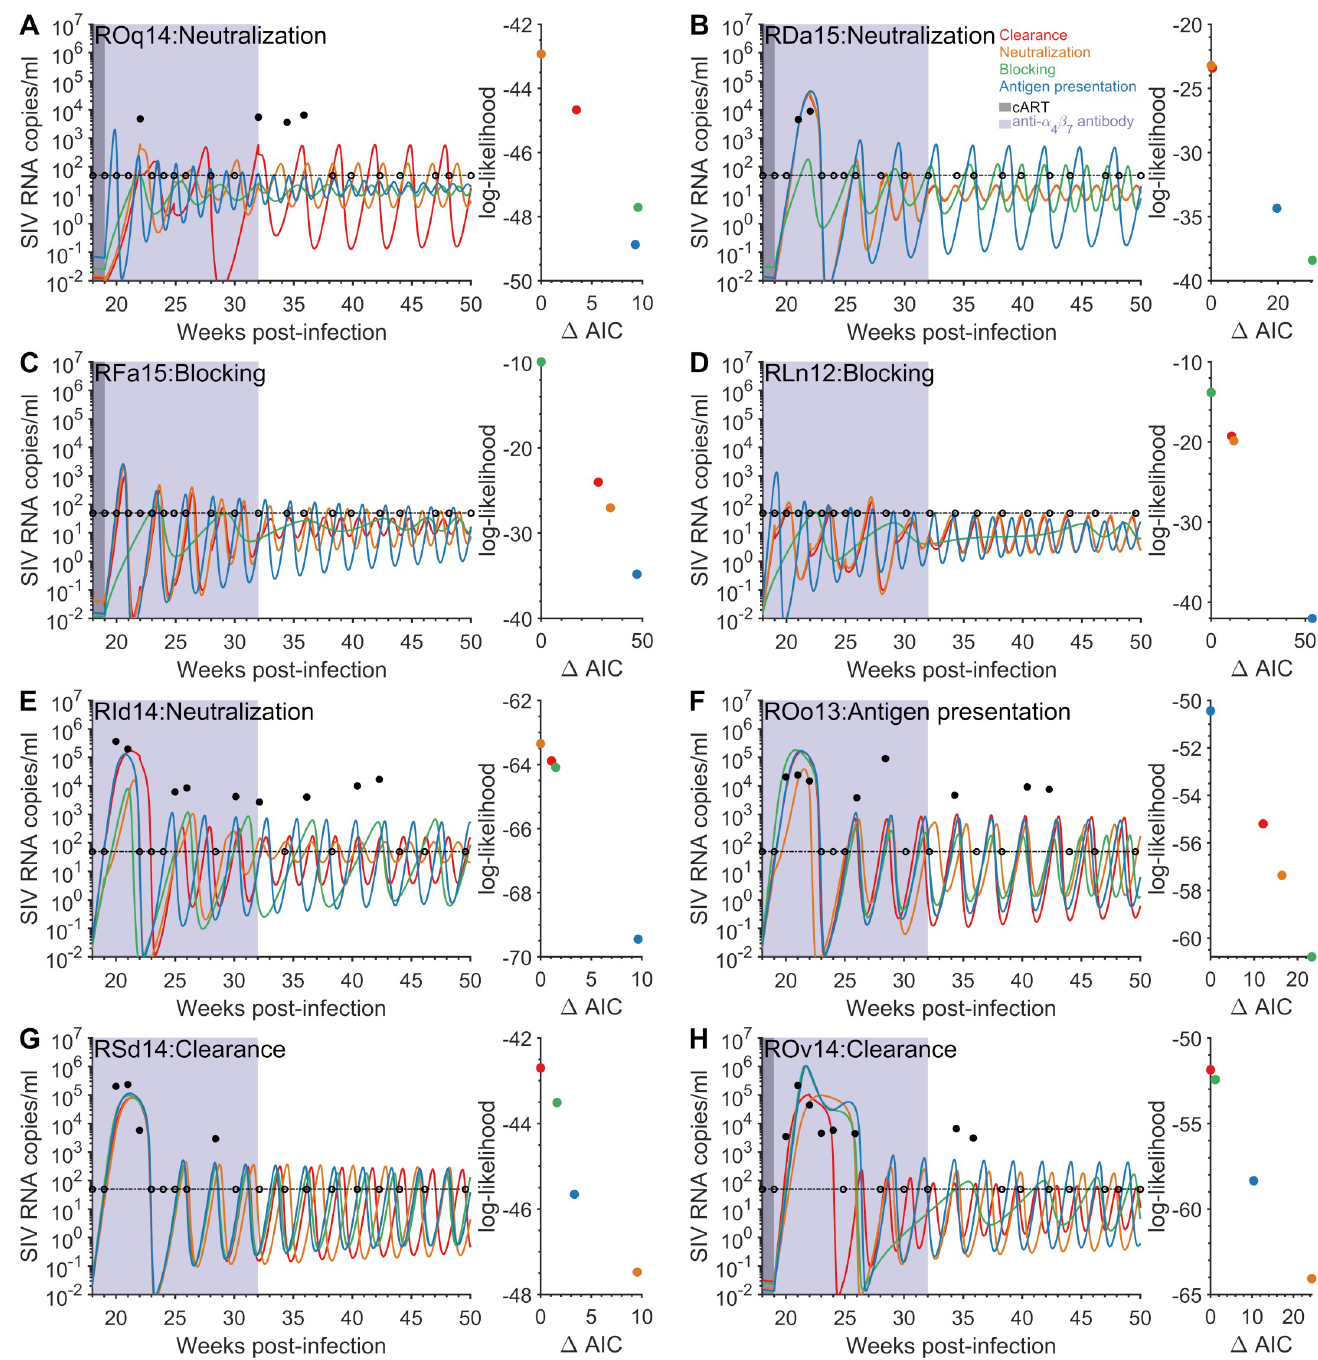
Fig 3. Viral dynamics after the removal of cART for the four anti- α 4 β 7 antibody mechanisms of action. The measured ( � 50 SIV RNA copies/ml solid circles and < 50 SIV RNA copies/ml open circles) and model predicted viral loads for the AIC selected model (indicated after macaque) and three remaining models using the best-fit parameter estimates for the mechanisms of increased viral clearance (red line), viral neutralization (orange line), target cell protection (green line), and increased antigen presentation (blue line), panels A)–H). For each macaque, a scatter plot of the Δ AIC and the log-likelihood for each mechanism, panels A)–H). The limit of detection is 50 SIV RNA copies/ml (thin horizontal dashed black line). Treatment with cART occurred between five weeks and 18/19 weeks post- infection (gray area), while eight infusions of the anti- α 4 β 7antibody occurred between nine weeks post-infection and 32 weeks post-infection (purple area). The mechanisms considered include parameters for these simulations are in Tables 1 and